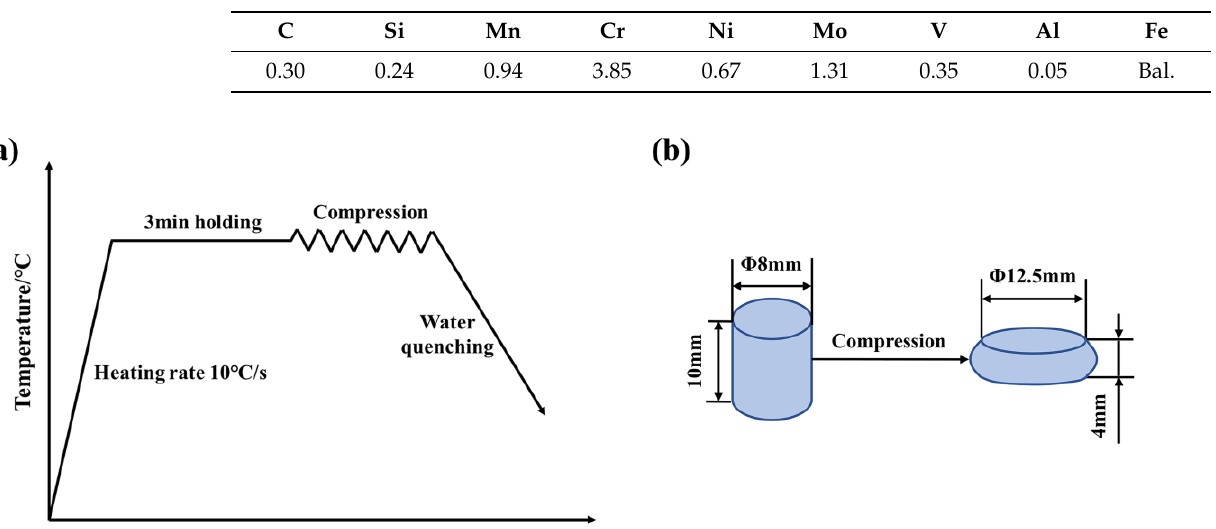
Table 1. Chemical component of 30Cr4MoNiV ultra-high-strength steel (wt.%).